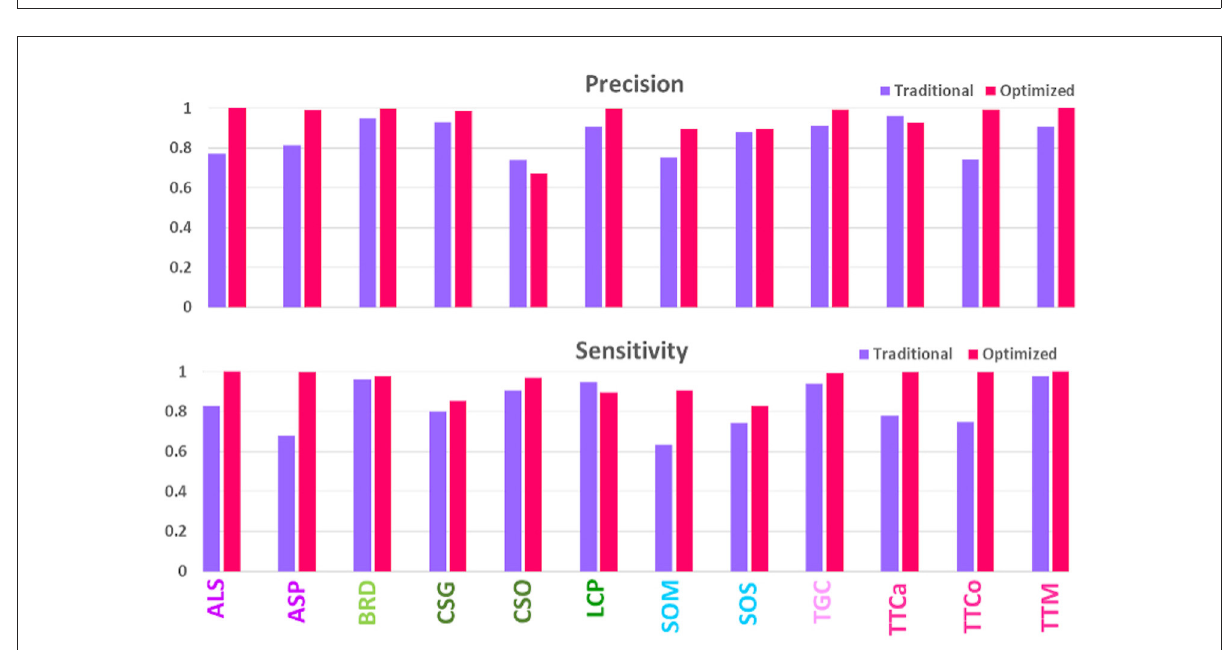
FIGURE3 Comparison of model performances on validation sets of traditionally- and optimally-acquired images.